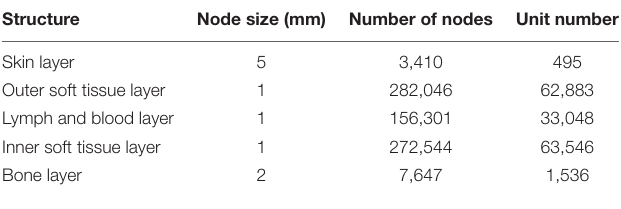
TABLE 3 | Unit number and node number in each layer of the forearm